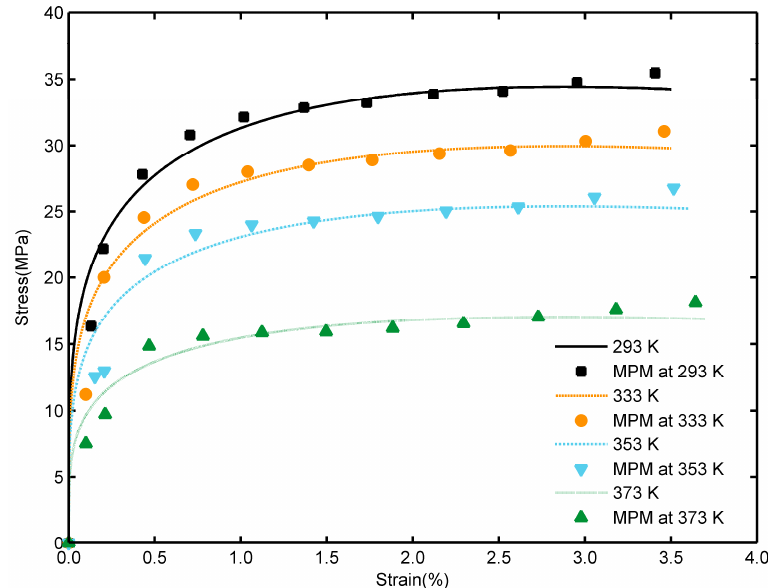
Figure 6. Constitutive curves fitted at different temperatures; data points are simulation results of MPM.